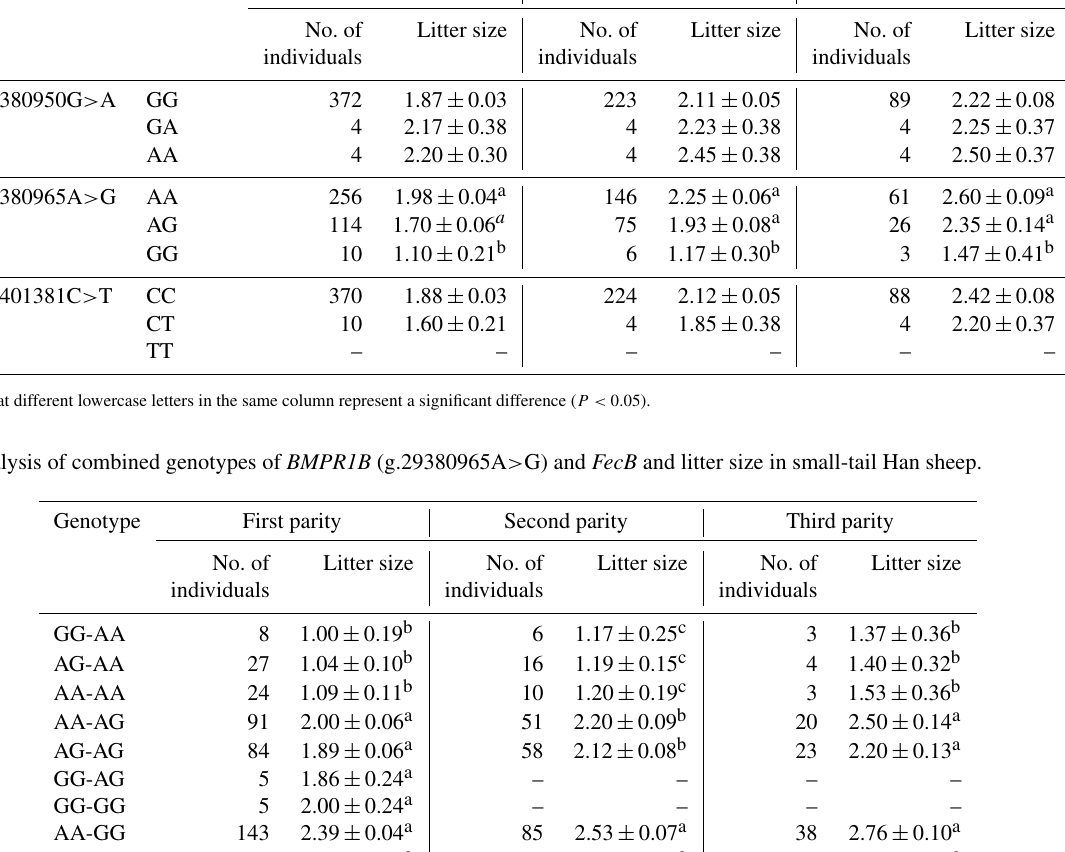
Table 5. Analysis of different genotypes of BMPR1B and litter size in small-tail Han sheep. Locus